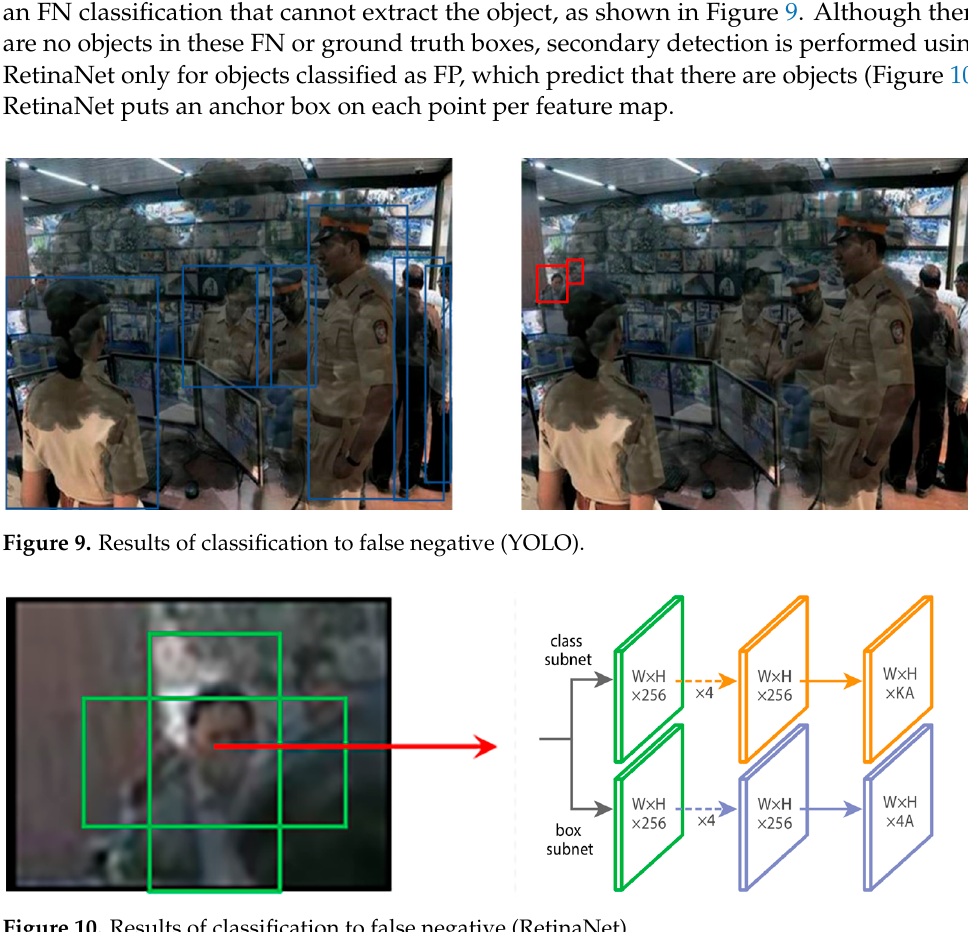
Figure 11. Image showing results of secondary detection using RetinaNet.